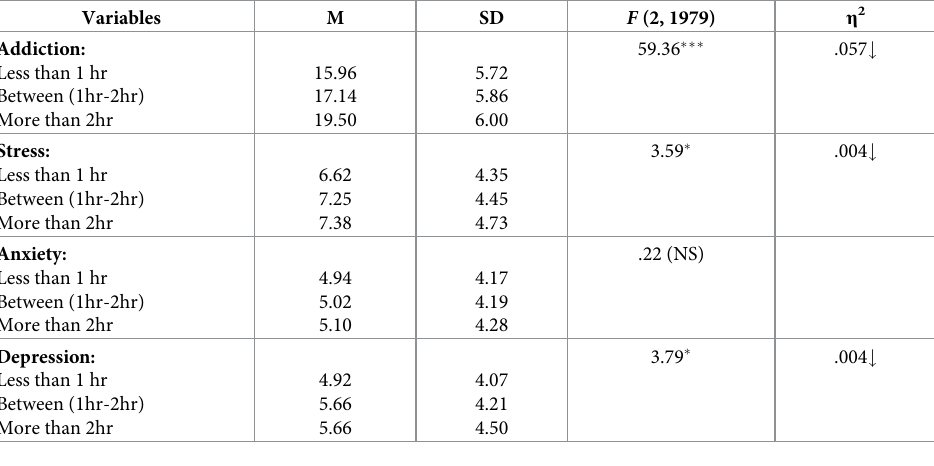
Table 3. Means, SDs, and ANOVA for the variables according to the total hours of SD use per session. Variables M